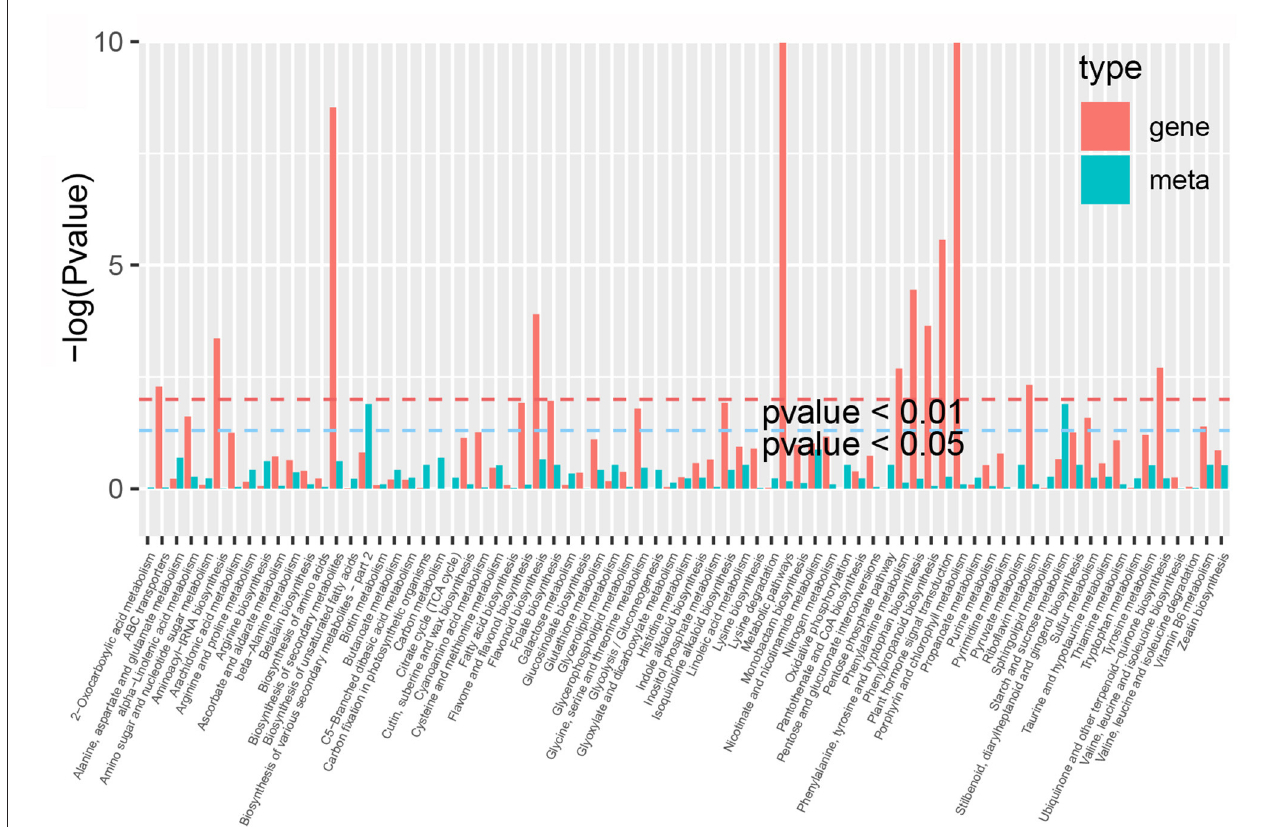
FIGURE 8 | KEGG enrichment analysis of the differentially expressed genes (red column) and differentially accumulated metabolites (green column) that were enriched in the same